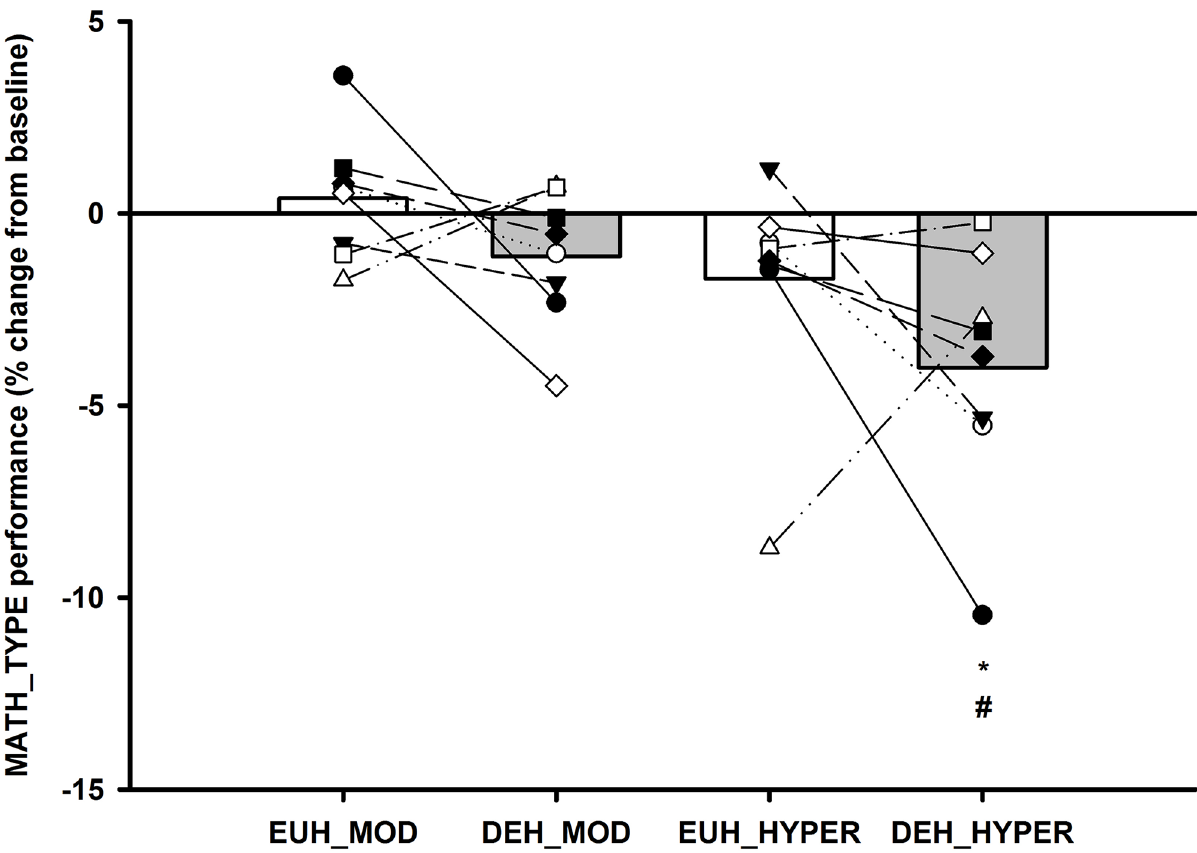
Fig 4. MATH_TYPE performance score. Individual and mean changes in MATH_TYPE performance during euhydration (EUH: MOD and HYPER [White bars]) and dehydration (DEH: MOD and HYPER [Grey bars]). Values are expressed in percentage change from BASELINE (BASELINE expressed as 0) and individual participant changes in each condition and session. (cid:3) Significantly different from BASELINE and # significantly different from MOD (P < 0 . 05) .